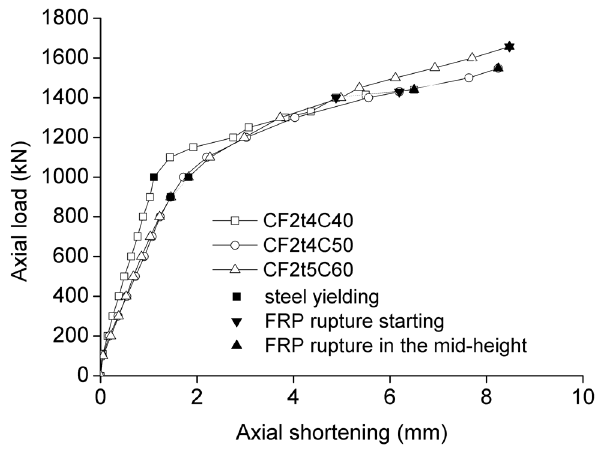
Figure 6. Axial load vs. axial shortening curves in terms of concrete